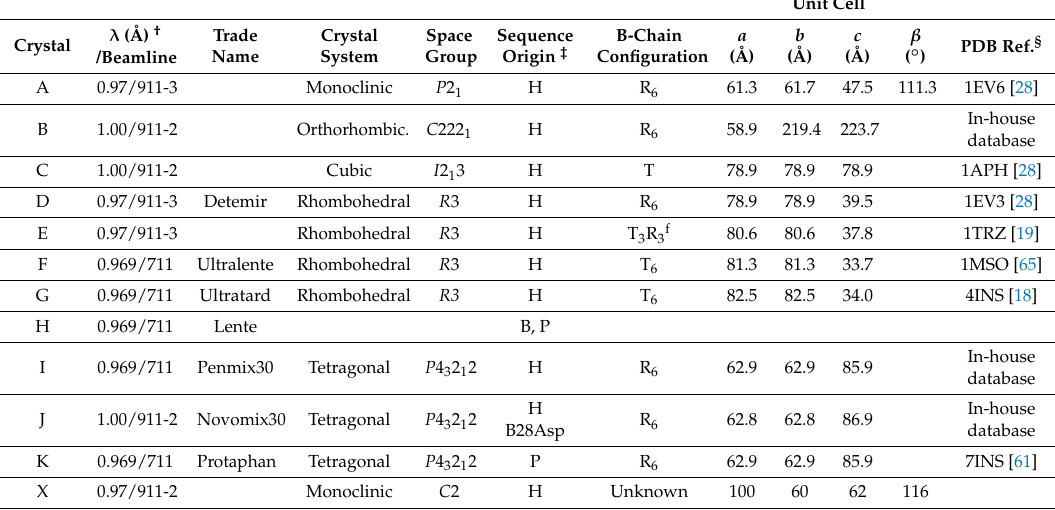
Table 2. Crystallographic properties of all insulin samples employed for structural investigation.